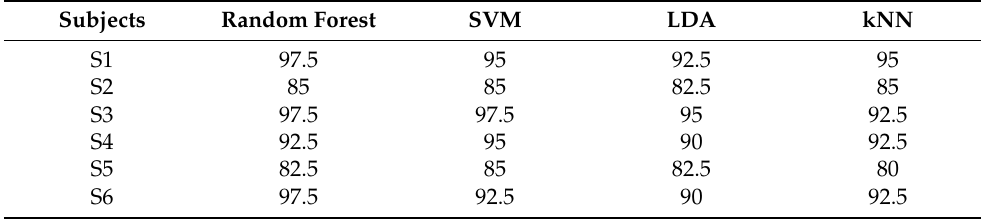
Table 3. Comparison of classification accuracies using RF, SVM, LDA, and kNN